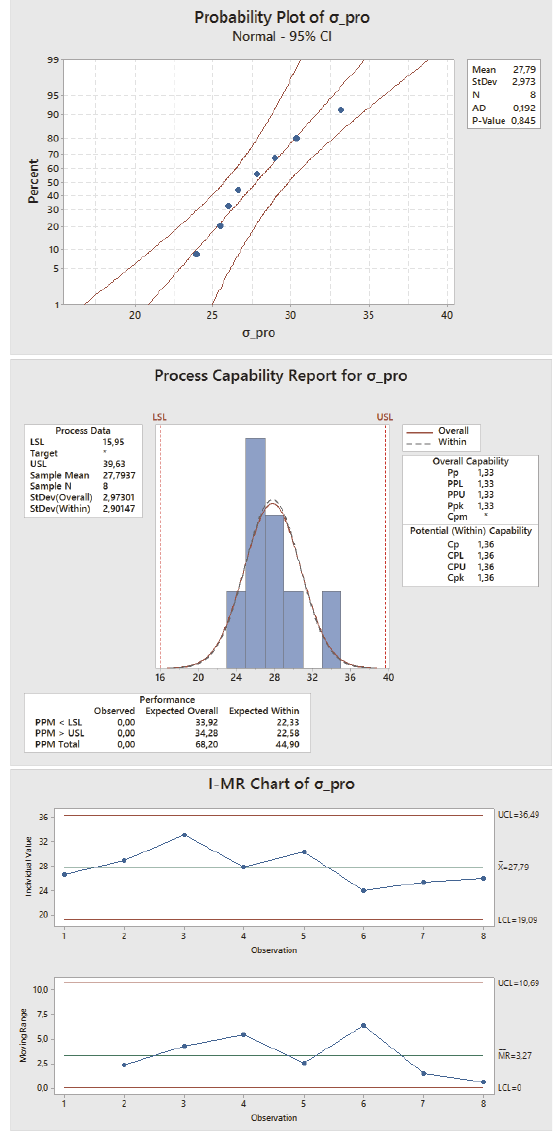
Figure 25: Probability Plot, Process Capability Report and I-MR Chart for the stress at proportional limit ( σ pro ) of